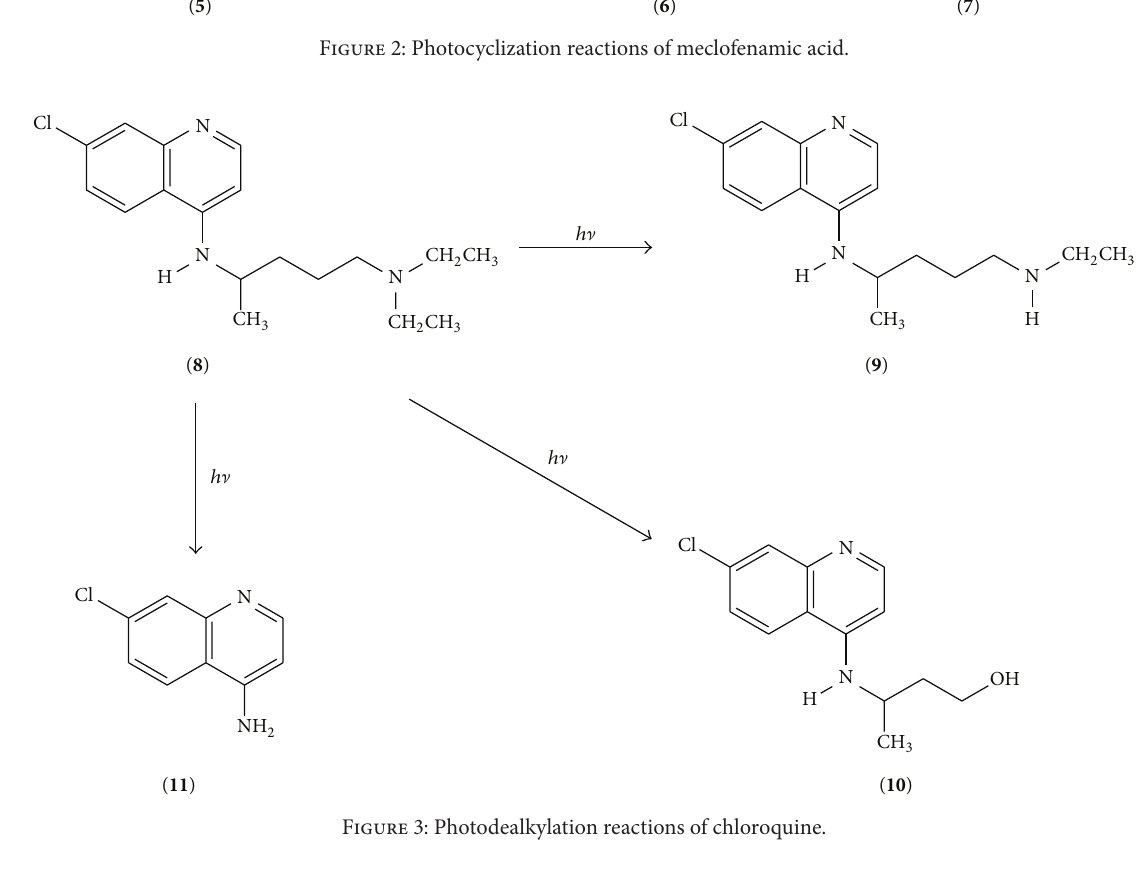
Figure 3: Photodealkylation reactions of